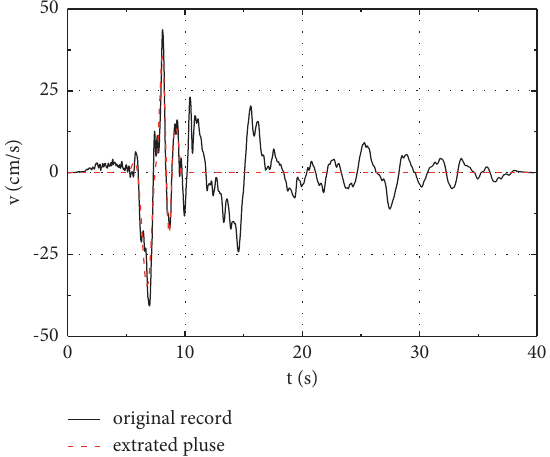
Figure 12: The velocity pulse and pulse-like ground motion. Table 1: The velocity pulse